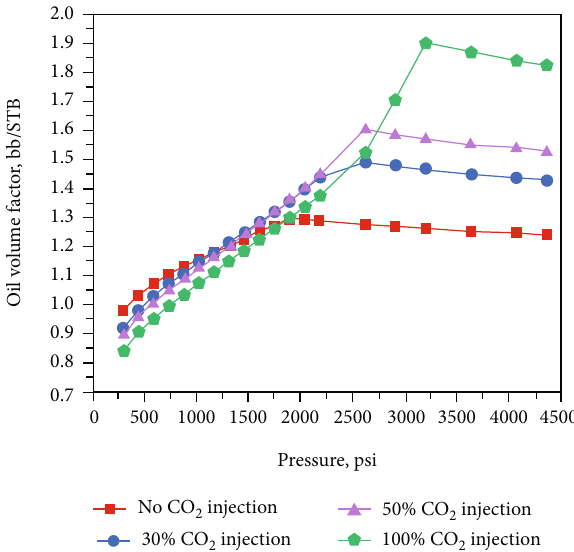
Figure 12: Oil volume factor of the Bakken tight oil versus pressure injections at T = 230 ° at various CO 2